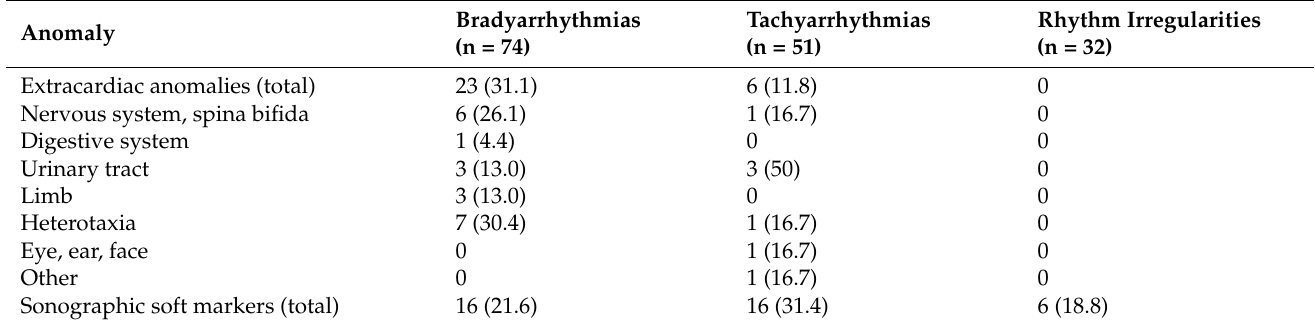
Table 4. Extracardiac anomalies and sonographic soft